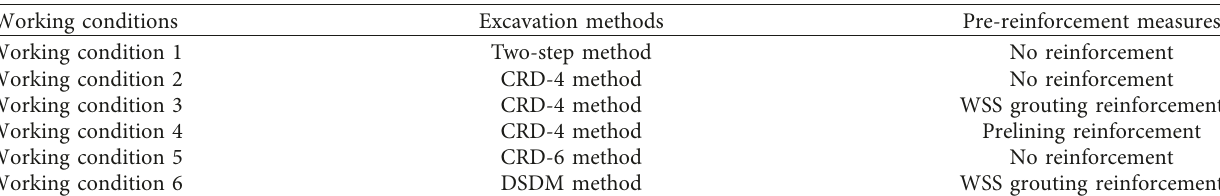
Table 4: Test condition of model